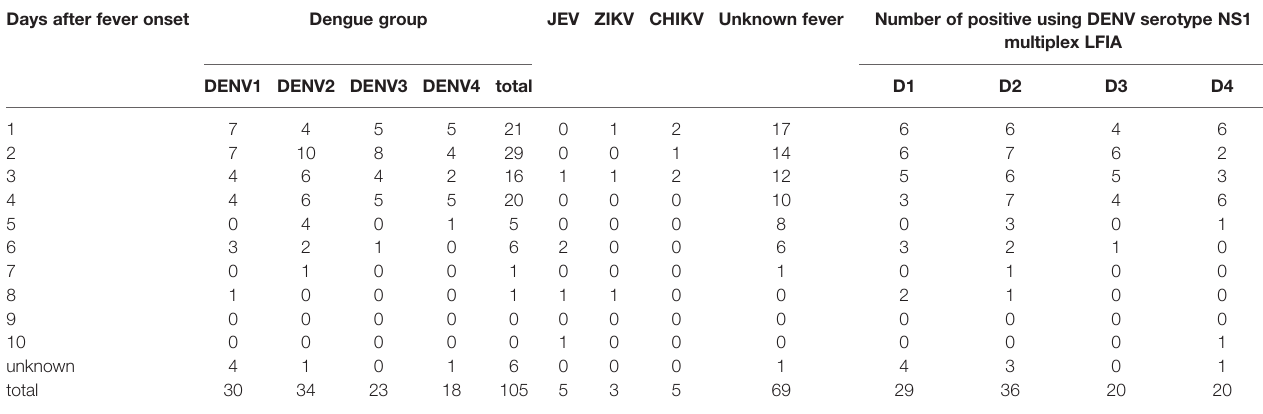
TABLE 5-2 | Description of serum samples (n=187) used in evaluating the performance of DENV serotype NS1 multiplex LFIA according to the DENV serotype, JEV, ZIKV, and CHIKV as well as days after fever onset. Days after fever onset